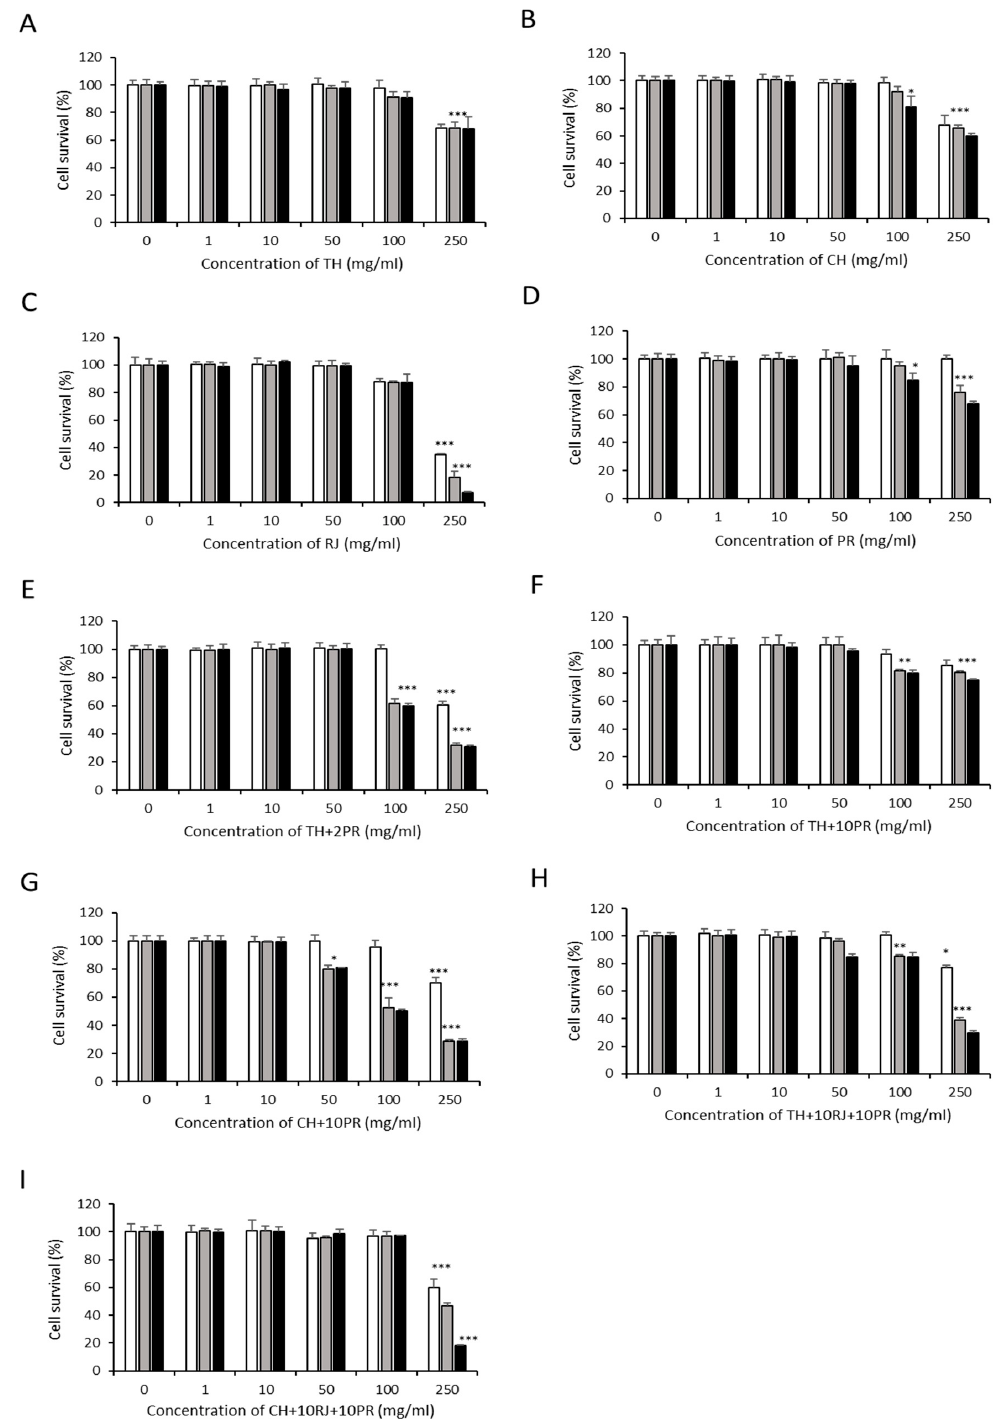
Figure 1. Effects of sample 1 (TH) ( A ), sample 6 (CH) ( B ), sample 15 (RJ) ( C ), sample 16 (PR) ( D ), sample 4 (TH+2PR) ( E ), sample 5 (TH+10PR) ( F ), sample 10 (CH+10PR) ( G ), sample 12 (TH+10RJ+10PR) ( H ), and sample 14 (CH+10RJ+10PR) ( I ) on WRL-68 cells’ viability by MTT assay. Cells were cultured with different doses of samples (0–250 mg/mL) for 24 ( □ ), 48 ( ■ ), and 72 h ( ■ ). Asterisks indicate a significant difference from the control (0). * p ≤ 0.05, ** p ≤ 0.01, *** p ≤ 0.001.